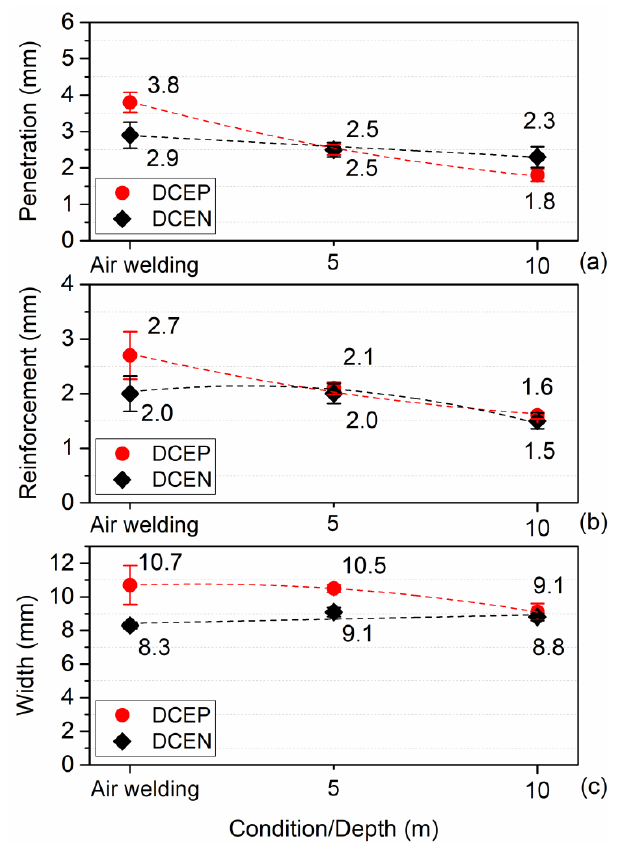
Figure 11. Averages values of weld bead penetration ( a ), reinforcement ( b ), and width ( c ) for rutile electrode in both polarities and for all conditions. Error bars show the standard deviation. In DCEP polarity, the process was more sensitive to the effect of depth, as can be seen in the variation in weld bead geometry. For the 10 m depth, the reinforcement and width did not change with polarity. In relation to the penetration and the melting rate for the greatest depth used in the study (10 m), the penetration was higher in welds made with DCEN and the melting rate was lower in this polarity, according to the model by Tsai and Masubuchi (1977) [14]. It was also established that, for welds produced in the air welding condition (i.e., the starting point of comparison), it is possible to show how, in DCEP polarity, the increase in depth made the cross section of the weld